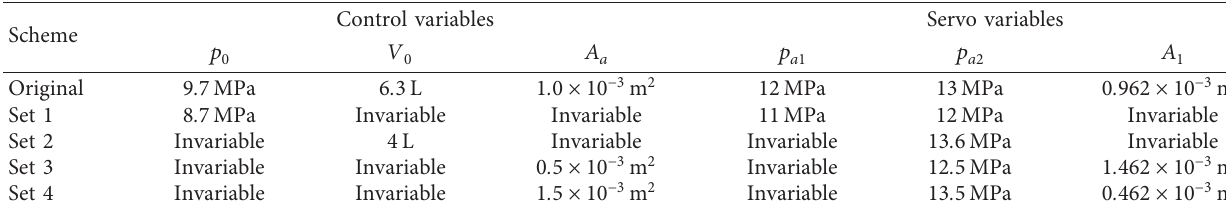
Figure 13: The power of the three systems in test 1. Table 4: Parameter configurations for the hydraulic accumulator.